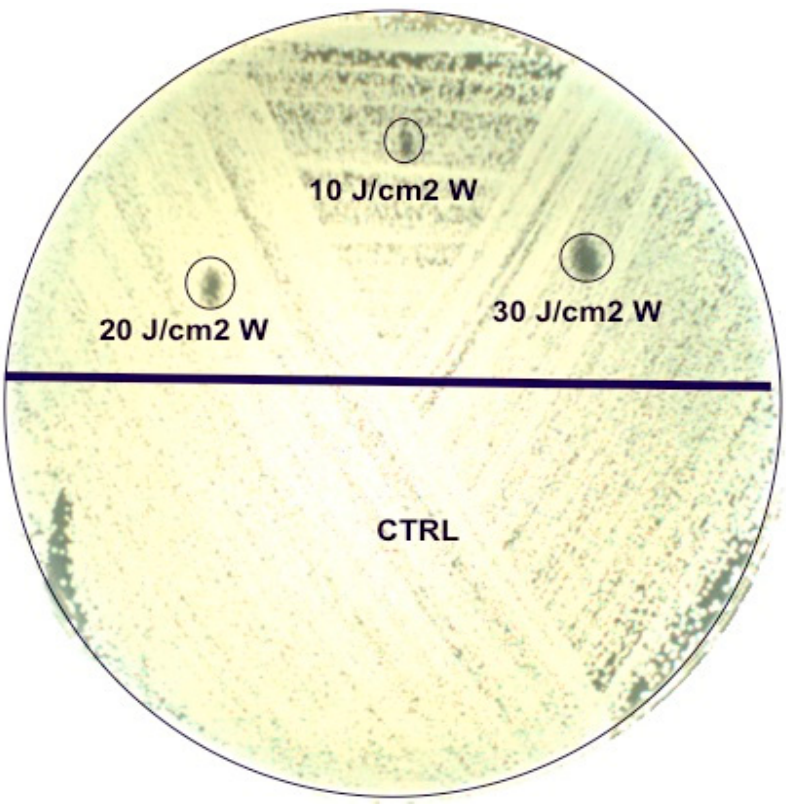
Figure 1. Agar plate irradiation with the three parameters on half of the plate (upper part), using the remaining half as a control.